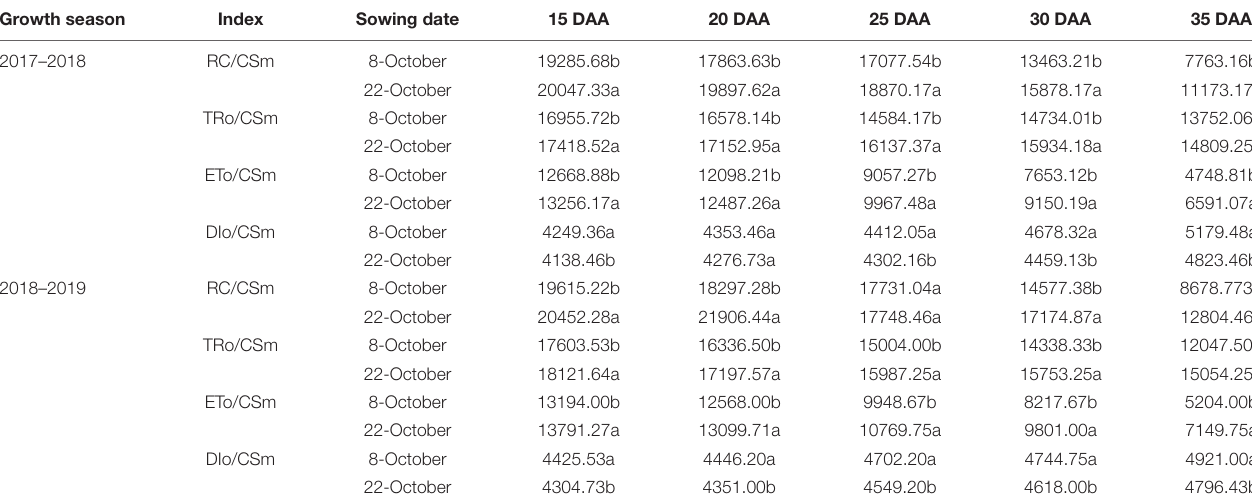
TABLE 1 | Effect of delayed sowing on the energy fluxes per excited cross section of wheat flag leaves under heat stress at late grain–filling stage. Growth